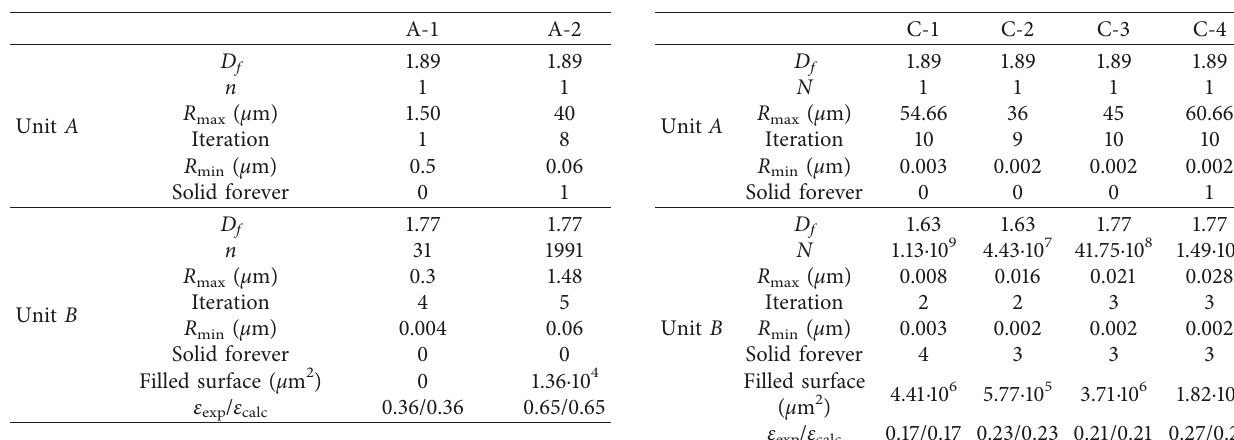
Table 1: IFU input data to models A-1 and A-2. The fractal di- mension ( D f ), the maximum ( R max ) and minimum rays ( R min ), the number of iterations, the number of solid forever squares for each base unit (the Sierpinski carpet), the number of B base units ( n B ), the filled surface (FS) used to build the IFU, and comparison between experimental ( ε exp ) and predicted pore volume fractions ( ε IFU ).